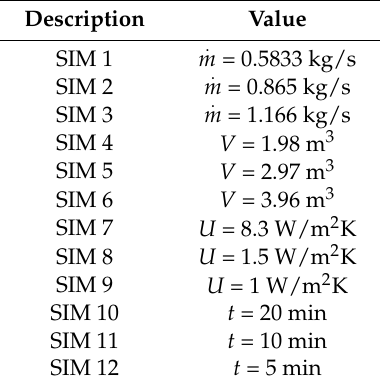
Table 2. Description of the Simulations